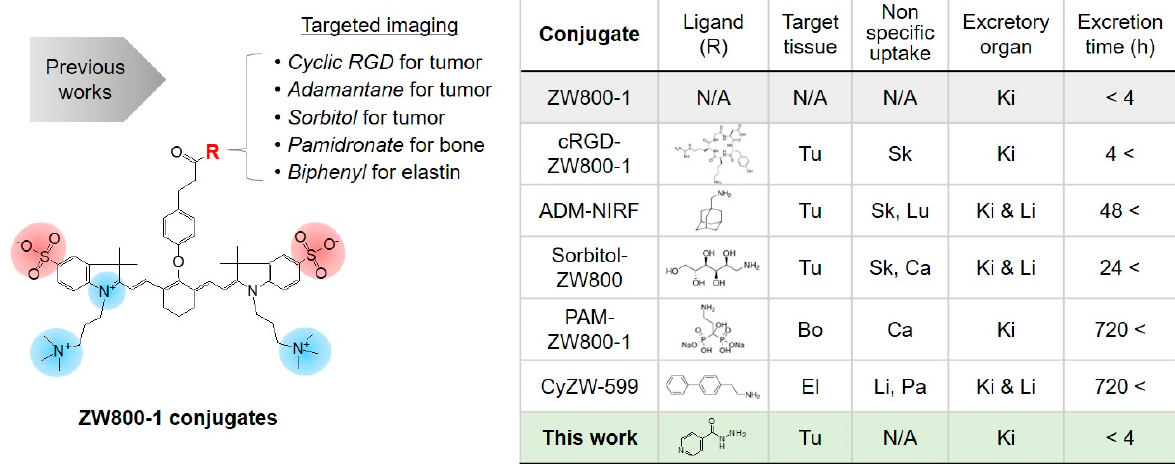
Figure 1. Structures of ZW800-1 [15] and its conjugates with various targeting ligands (e.g., cRGD-ZW800-1 [8], ADM- NIRF [20], Sorbitol-ZW800 [7], PAM-ZW800-1 [17], and CyZW-599 [21]) reported previously for NIR fluorescence imaging. Comparison of in vivo performance characteristics from the current study and previous studies in terms of targetability, nonspecific tissue/organ uptake, and excretion time. Abbreviations: Bo, bone; Ca, cartilage; El, elastin; Ki, kidneys; Li, liver; Lu, lungs; Pa, pancreas; Sk, skin; Tu, tumor; N/A, not applicable.